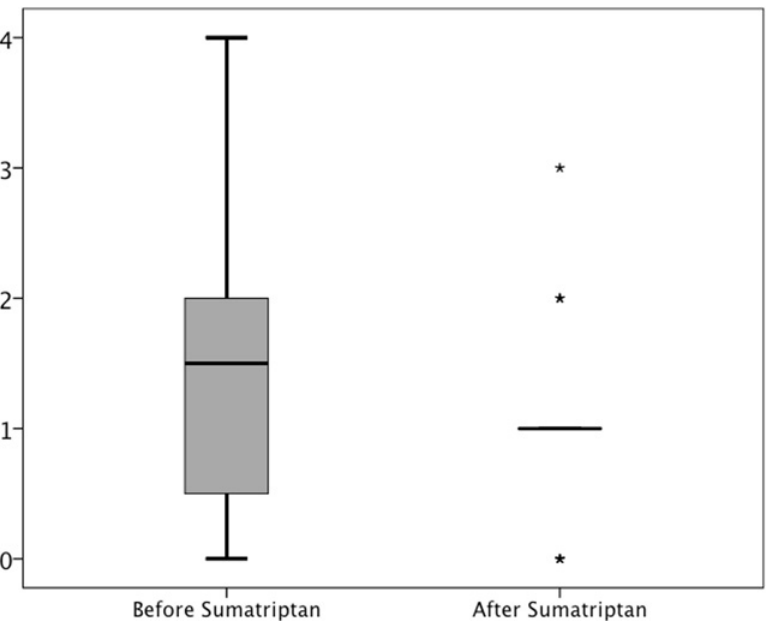
Fig 5. Headache score: Boxplot of median headache on the CGRP day before (T 40 ) and after sumatriptan injection (T 65 ). Stars ( * ) symbolize outliers. Before sumatriptan administration there was a median headache of 1.5 on the verbal rating scale (VRS) (range: 0 – 4). After treatment with sumatriptan the median headache intensity dropped to VRS 1.0 (range 0 – 3) (P = 0 . 099) .